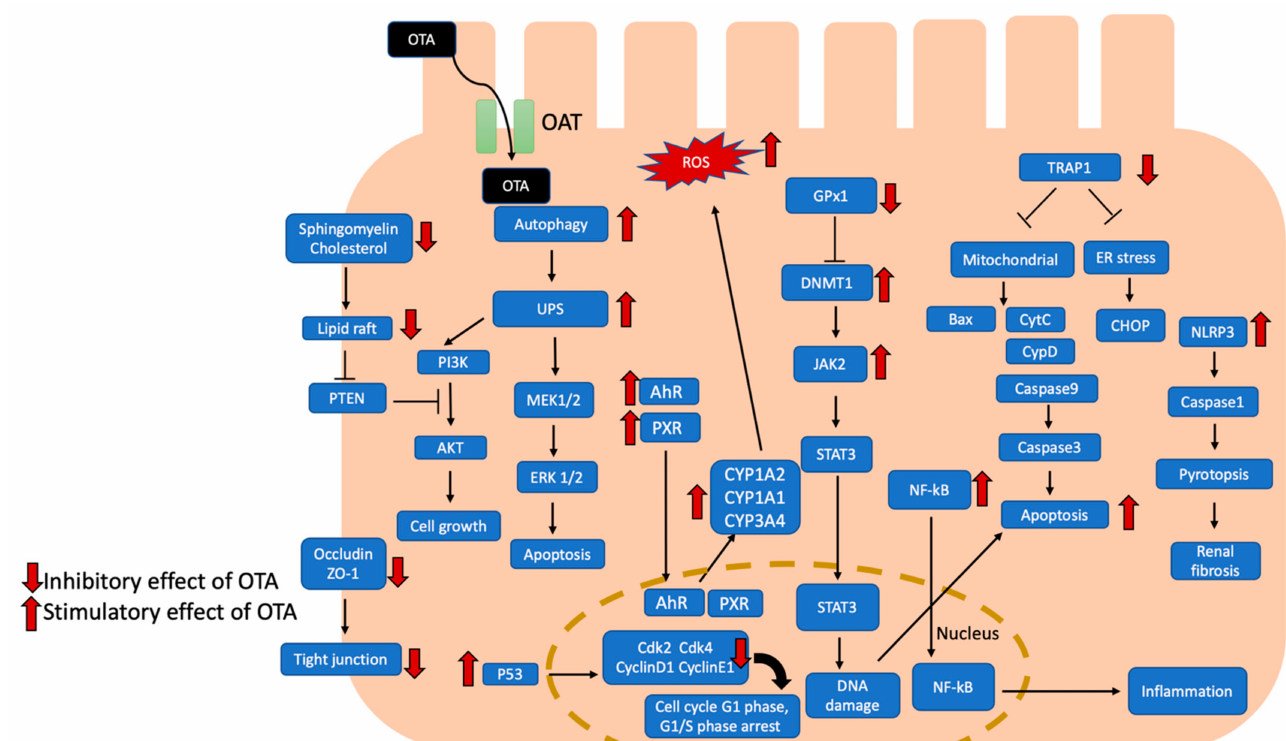
Figure 1. Effects of OTA-induced nephrotoxicity are illustrated, and the potential signal pathways are summarized. OTA uptake by proximal tubular cells with organic anion transporter. OTA activates AhR and PXR signaling pathways to induce cytochrome P450 1A1 (CYP1A1), CYP1A2, and CYP3A4, leading to increased ROS production. Meanwhile, OTA induced autophagy and UPS led to apoptosis with MEK1/2/ERK1/2 pathway. OTA attenuated cholesterol and sphingomyelin to disrupt lipid raft formation which led to cell apoptosis through PTEN/PI3K/AKT pathway. Besides, OTA inhibited occluding and ZO1 to disrupt tight junction. In addition, OTA activated DNMT1-dependent JAK2/STAT3 signaling pathway to induce apoptosis and DNA damage. OTA could promote NF-kB translocated to nucleus which induced inflammation. OTA also inhibits TRAP-1 which regulated mitochondria-mediated and ER stress-excited apoptosis. Furthermore, OTA activated NRPL3 inflammasome and caused caspase1-dependent pyroptosis. OTA also activated p53 which suppressed cyclin D1, CDk2 and CDk4, leading to cell cycle arrest. AhR, aryl hydrocarbon receptor; Akt, serine/threonine-specific protein kinases; Bax, Bcl-2 associated x protein; Cdk2, cyclin dependent kinase 2; Cdk4, cyclin dependent kinase 4; CHOP, CAAT/enhancer-binding protein (C/EBP) homologous protein; CYP1A1, cytochrome P450 1A1; CYP1A2, cytochrome P450 1A2; CYP3A4, cytochrome P450 3A4; CytC, cytochrome C; DNMT1, DNA methyltransferase 1; ER stress, endoplasmic reticulum stress; ERK 1/2, extracellular signal-regulated kinases 1/2; JAK2, Janus kinase 2; MEK 1/2, mitogen-activated protein kinase kinase 1/2; NF- κ B, nuclear factor kappa-light-chain-enhancer of activated B cell; NLRP3, NLR family pyrin domain containing 3; OAT, organic anion transporter; PTEN, phosphatase and tensin homolog; PI3K, phosphoinositide 3-kinases; PXR, pregnane X receptor; ROS, reactive oxygen species; STAT3, signal transducer and activator of transcription 3; TRAP-1, tumor necrosis factor receptor-associated protein 1; UPS, ubiquitin-proteasome system; ZO-1, Zonula occludens protein